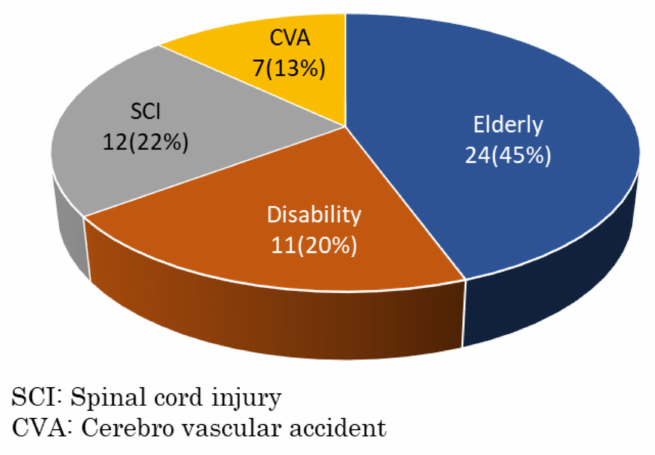
Figure 1. Summary of the classification of